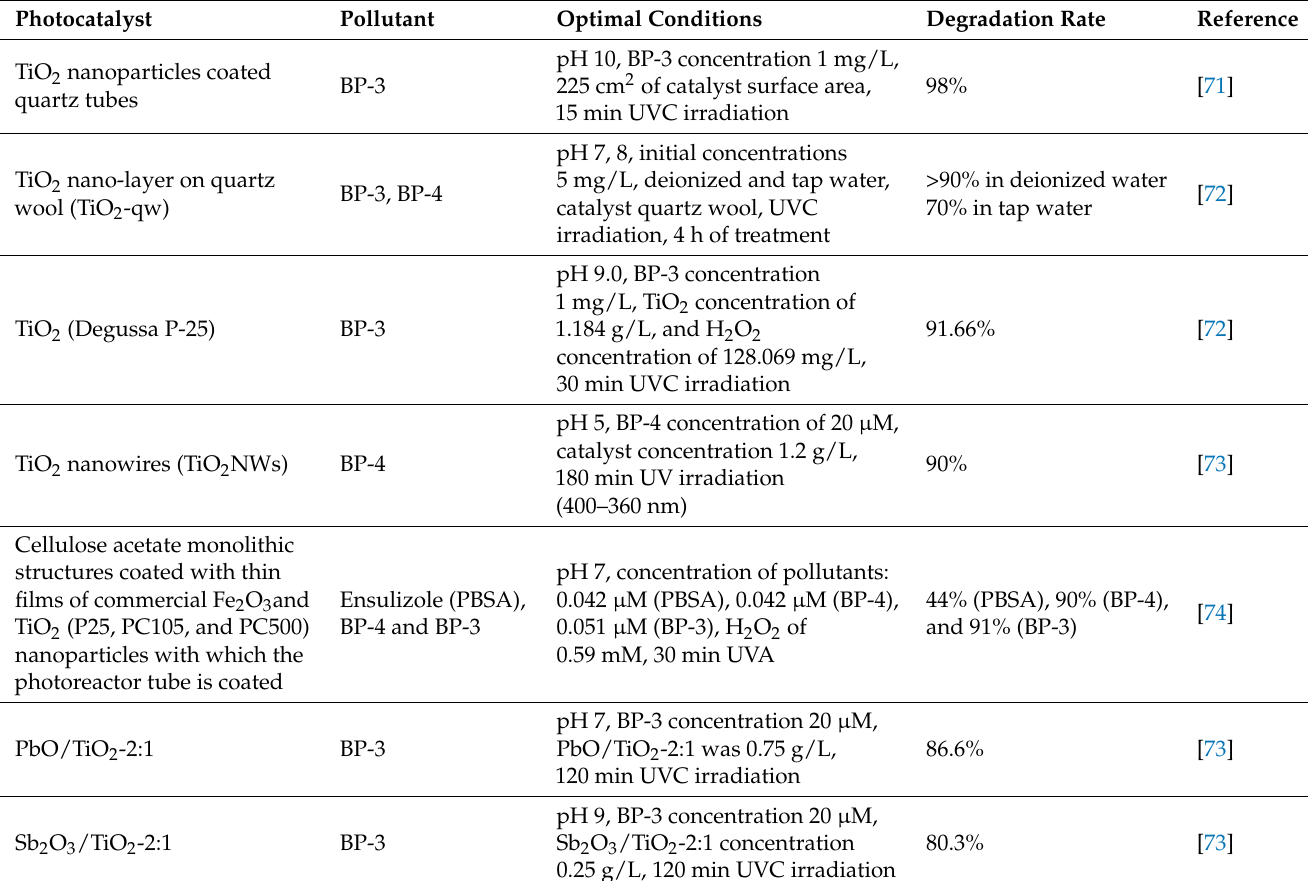
Table 3. Overview of the photocatalytic reactions used s in degradation reaction of